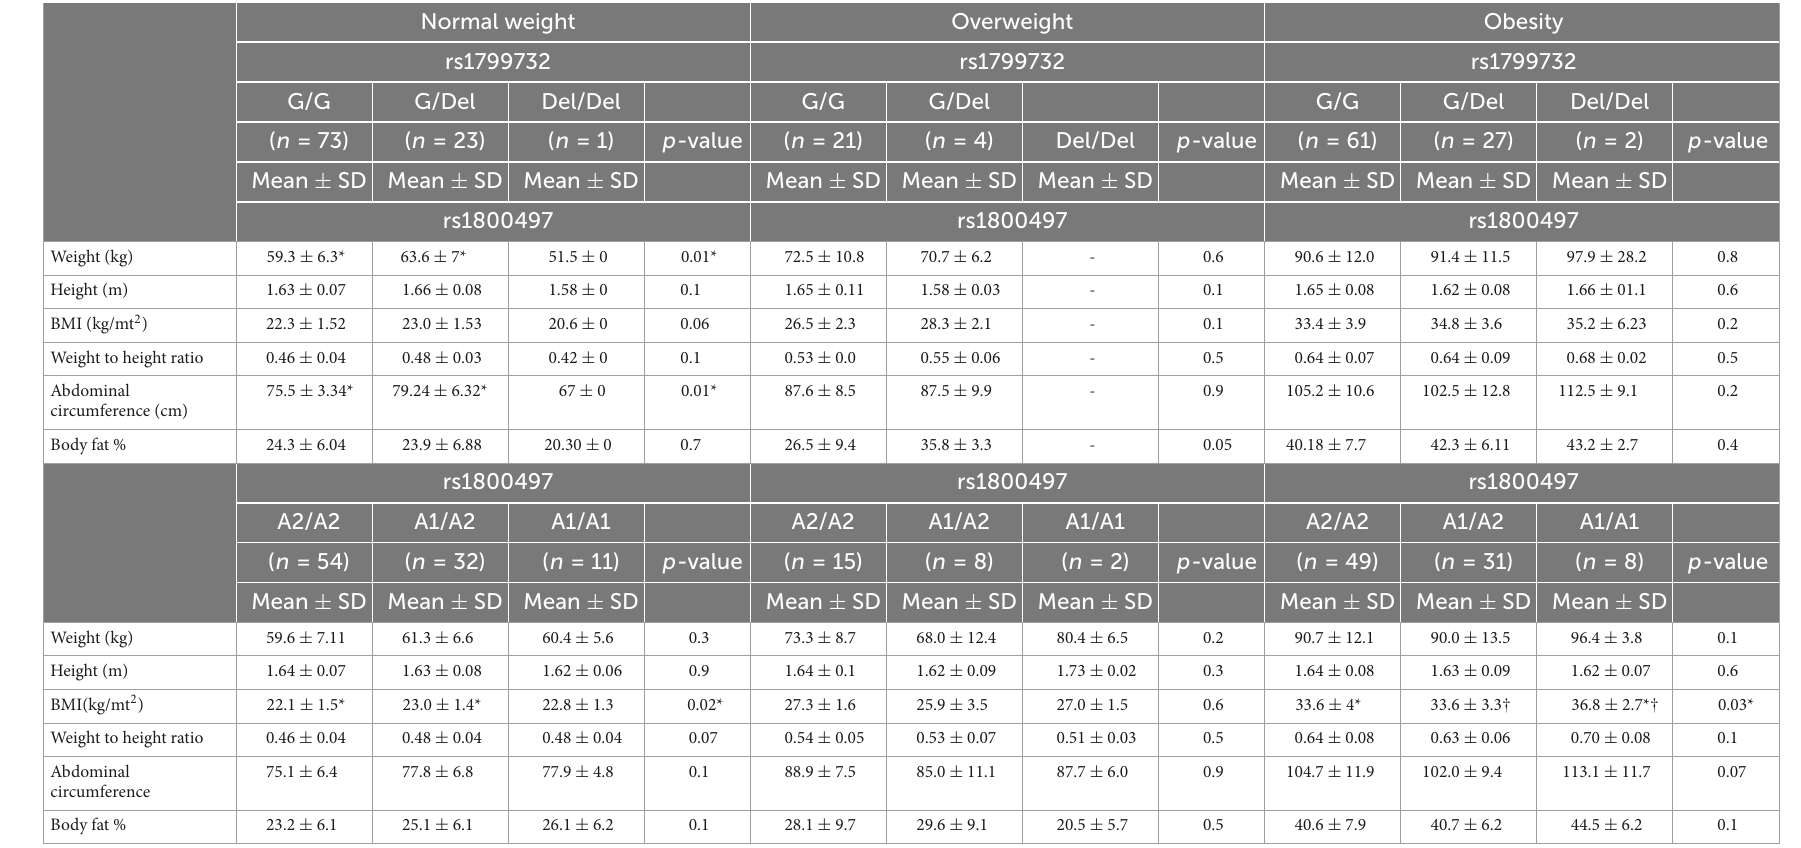
TABLE 1 Anthropometric measurements by genotype of rs1799732 and rs1800497 variants. Normal